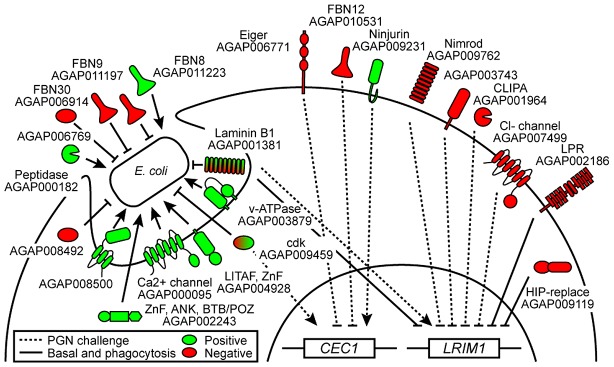
Schematic representation of the role of identified regulators in the An. gambiae hemocyte immune response.A total of 22 positive (green) and negative (red) regulators are shown. Dotted lines indicate modulations of CEC1 and LRIM1 gene expression upon PGN challenge, and solid lines describe the effect of genes on phagocytosis and basal expression of LRIM1.